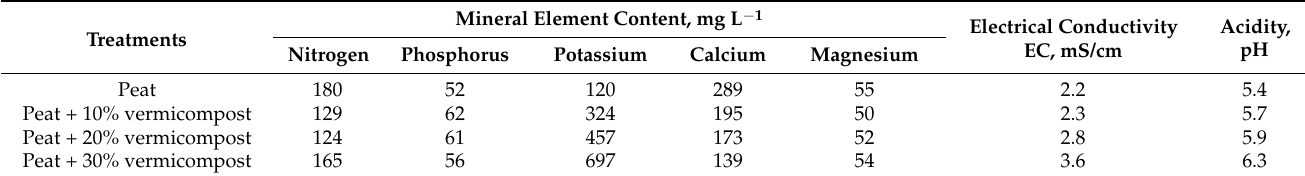
Table 1. Agrochemical characteristics of different substrates.